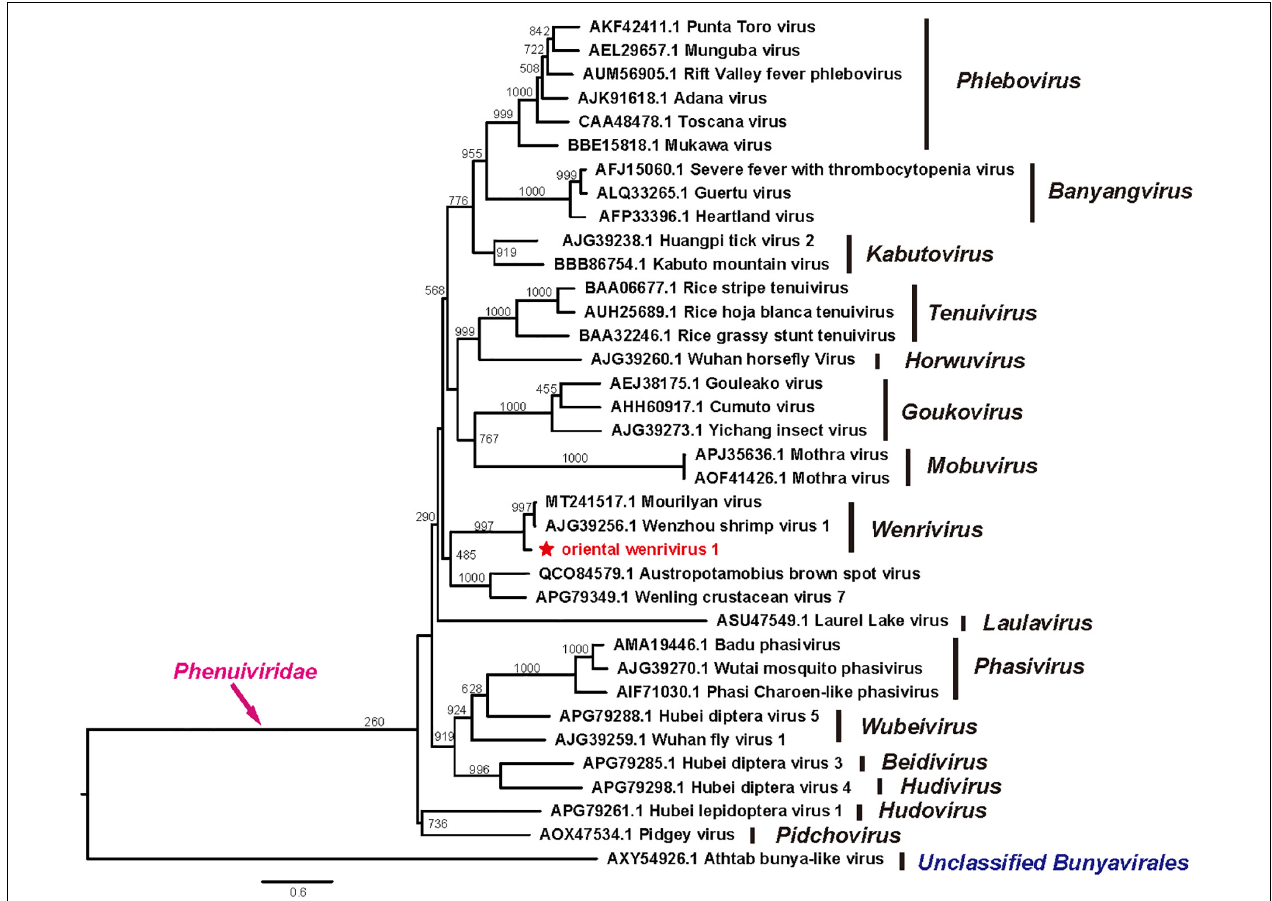
FIGURE 3 | Phylogenetic tree of the RdRp protein sequences of oriental wenrivirus 1 (OWV1) and representative viruses in the family Phenuiviridae . OWV1 is highlighted with a red star. Scale bar represents the number of amino acid substitutions per